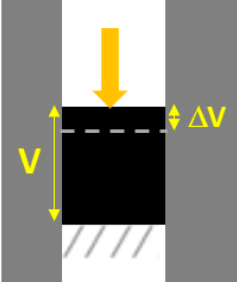
Figure 5. Volumetric compression in FEA model of conventional hanger seal